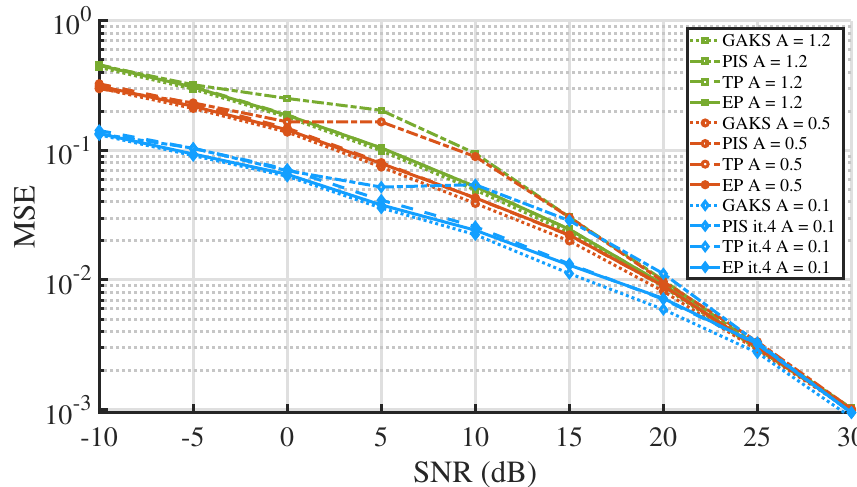
Figure 6. Signal estimation in Markov–Middleton noise with M = 4 states and Γ = 0.01 (as in Figure 5a). Different values of the average number of interferers A are